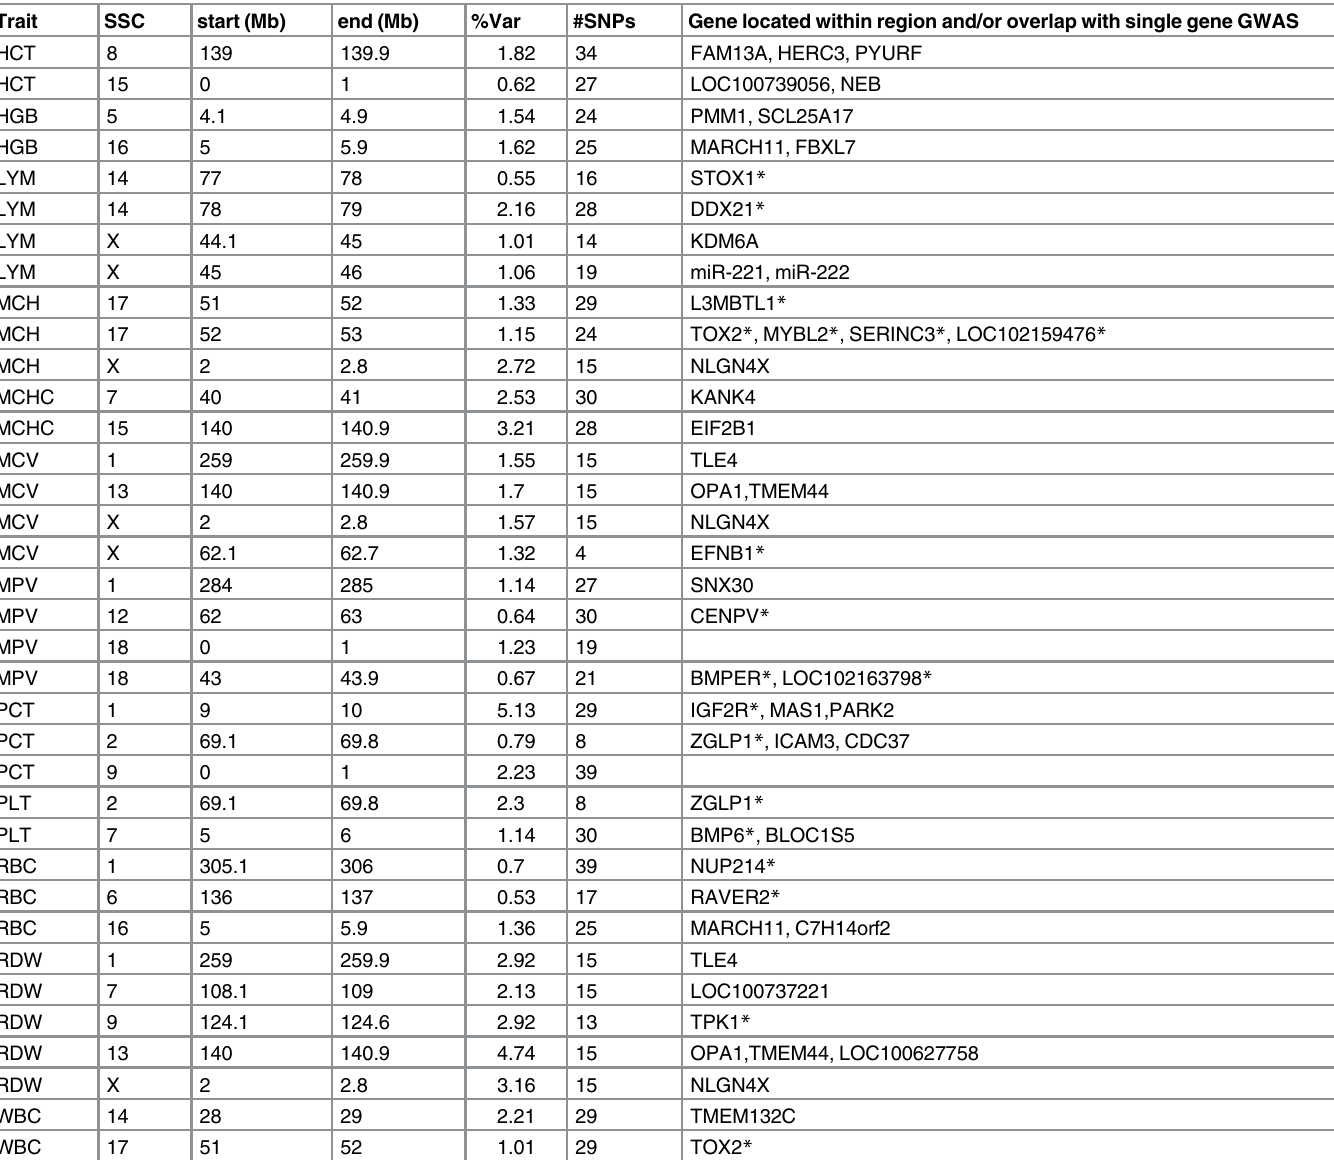
Table 3. Results of multi- (Bayesian approach) marker genome-wide association analysis in a commercial German Landrace pig population.